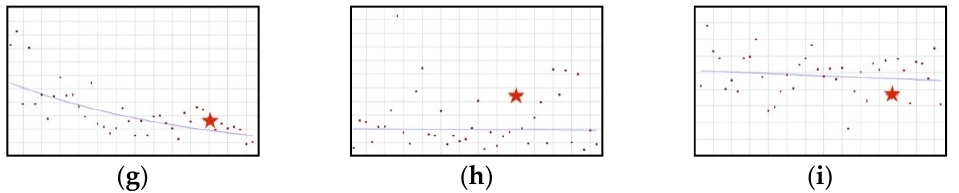
Figure 2. A schematic graph of the frequency of use of ingredients in the respective quarters in the period from the first quarter of 2012 to the fourth quarter of 2021. The star denotes the moment of publication of a scientific opinion or a resolution concerning the ingredient. The height of placement of the symbol reflects the level of use of the ingredient. ( a ): Aloe (Figure A7); ( b ): Caffeine (Figure A8); ( c ): Chromium (Figure A9); ( d ): ECGC (Figure A10); ( e ): Hoodia (Figure A11); ( f ): Niacin (Figure A12);